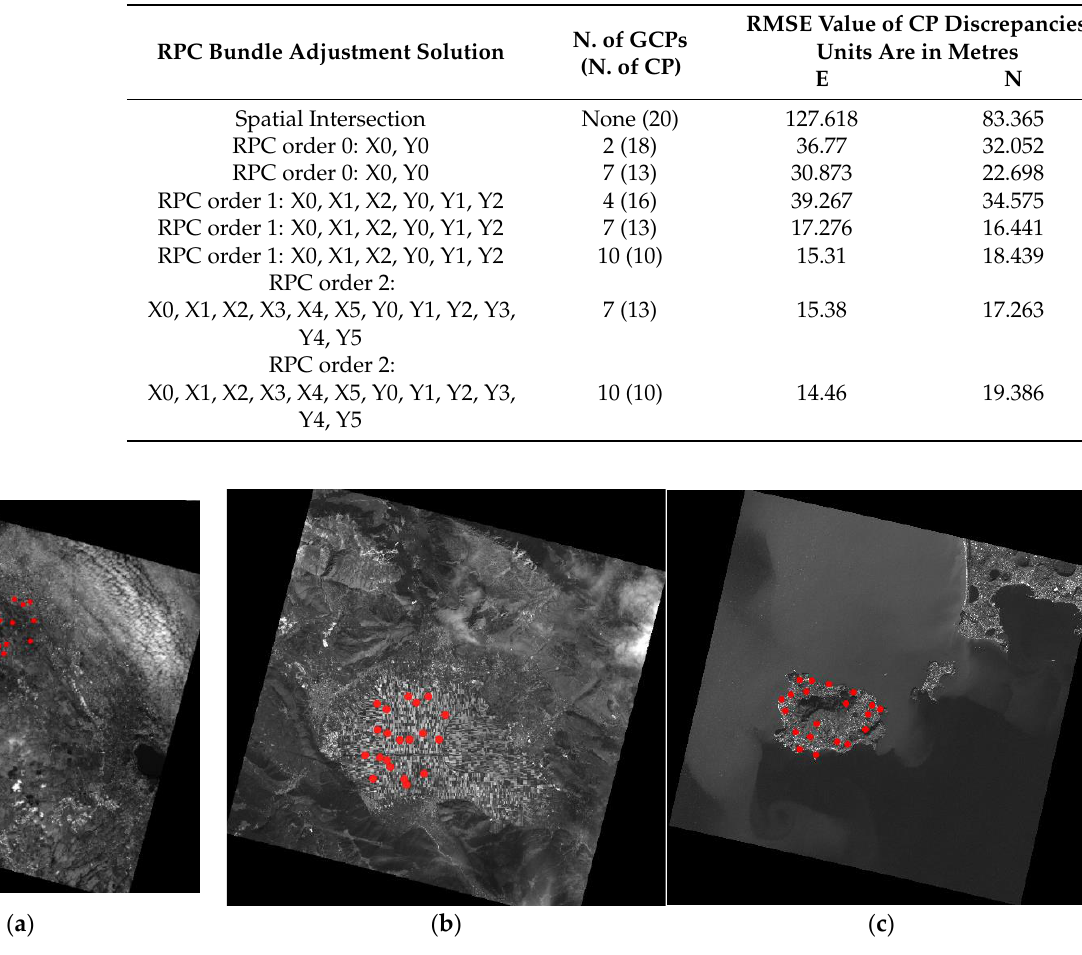
Figure 4. Ground point distribution for a central area of the image, test field of Rome ( a ), Fucino ( b ) and Ischia ( c ).